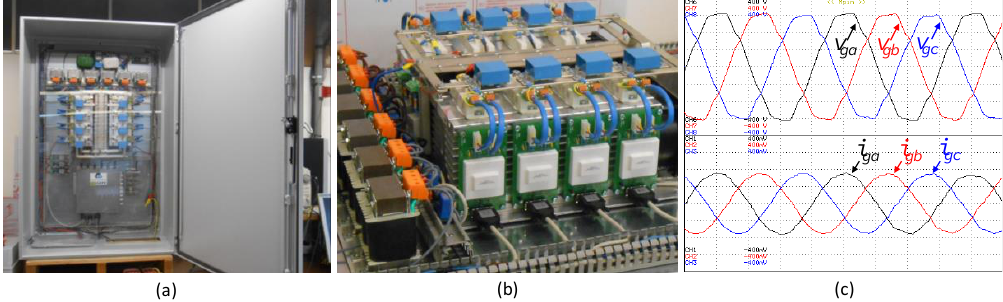
Figure 7. Main power electronics converters used as back-end power stage of off-board EVBC: ( a ) unidirectional interleaved buck-type; ( b ) bidirectional multilevel; ( c ) bidirectional three-phase isolated; ( d ) bidirectional multiple dual active bridge.